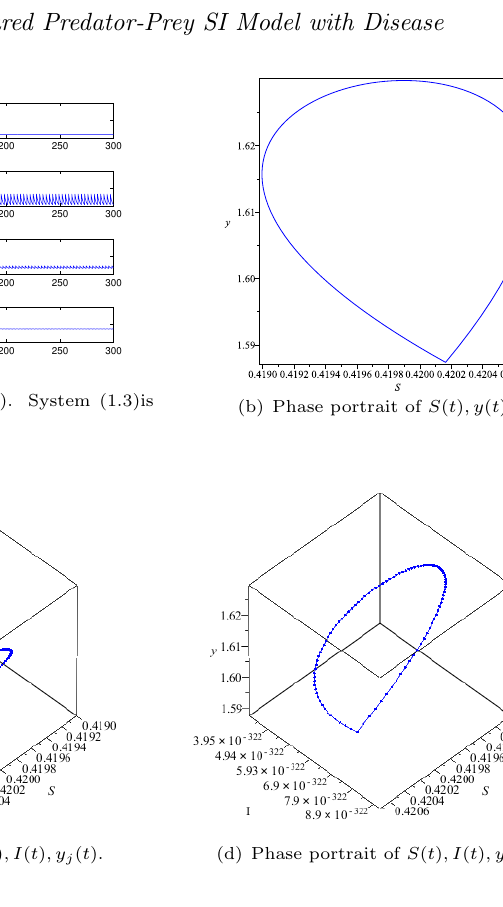
Figure 2. The results of numerical simulation on the threshold values R 2 = 1 . 6742, where l = 0 . 5; p = 0 . 3; q = 0 . 3, T = 3; τ =